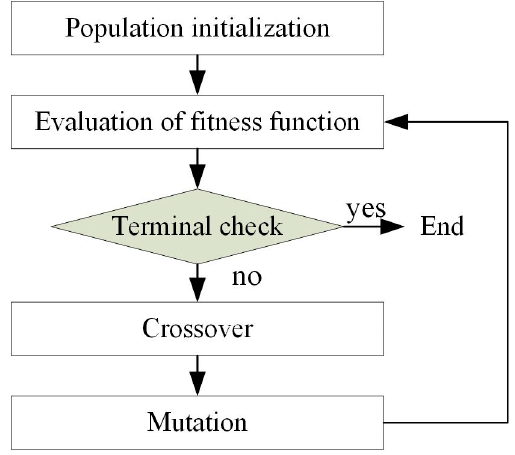
Figure 2. Workflow of the genetic algorithm.